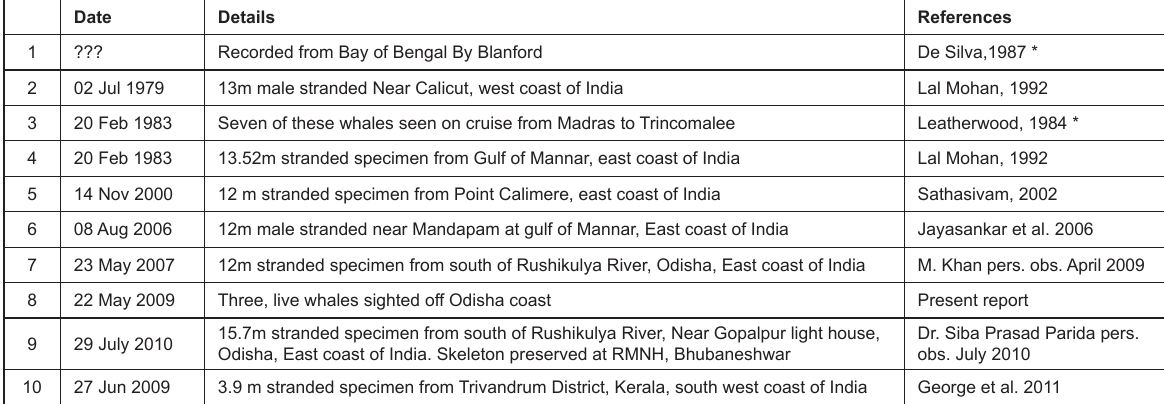
Table 1. Sighting and stranding records of Bryde’s Whale from Indian waters